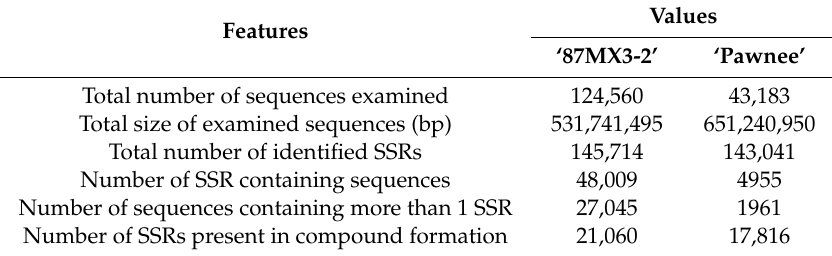
Table 2. Information of simple sequence repeats (SSRs) identified in the pecan genome.